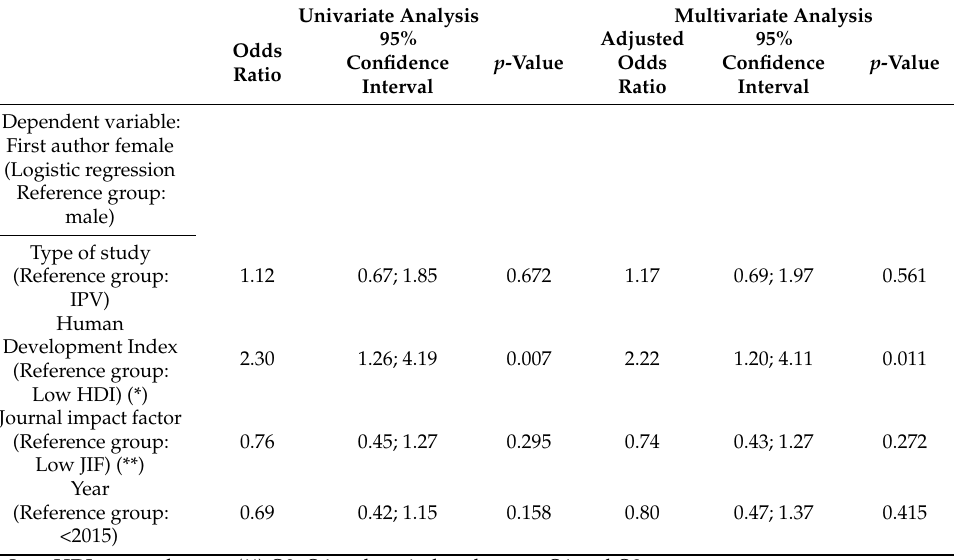
Table 3. Multivariate regression estimates of first author gender among prevalence studies of intimate partner violence (IPV) during pregnancy and prevalence of gestational diabetes mellitus (GDM)